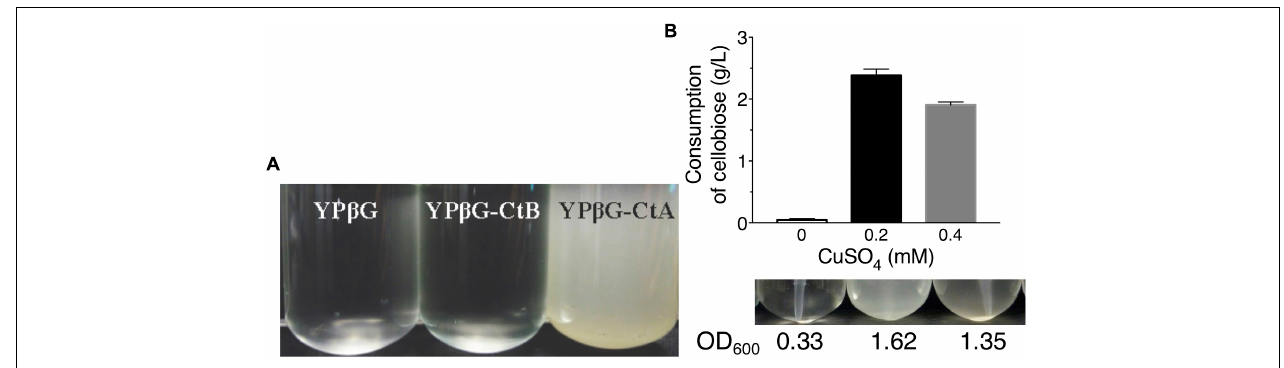
FIGURE 1 | The growth of yeast strains in the media with cellobiose as the sole carbon source. (A) Growths of yeast strain YP β G, YP β G-CtA, and YP β G-CtB in SM-Leu or SM-Leu-Ura media with cellobiose as the sole carbon source after 2 days. (B) The cellobiose utilization and cell growth of YP β G-CtA strain in the media containing a different concentration of